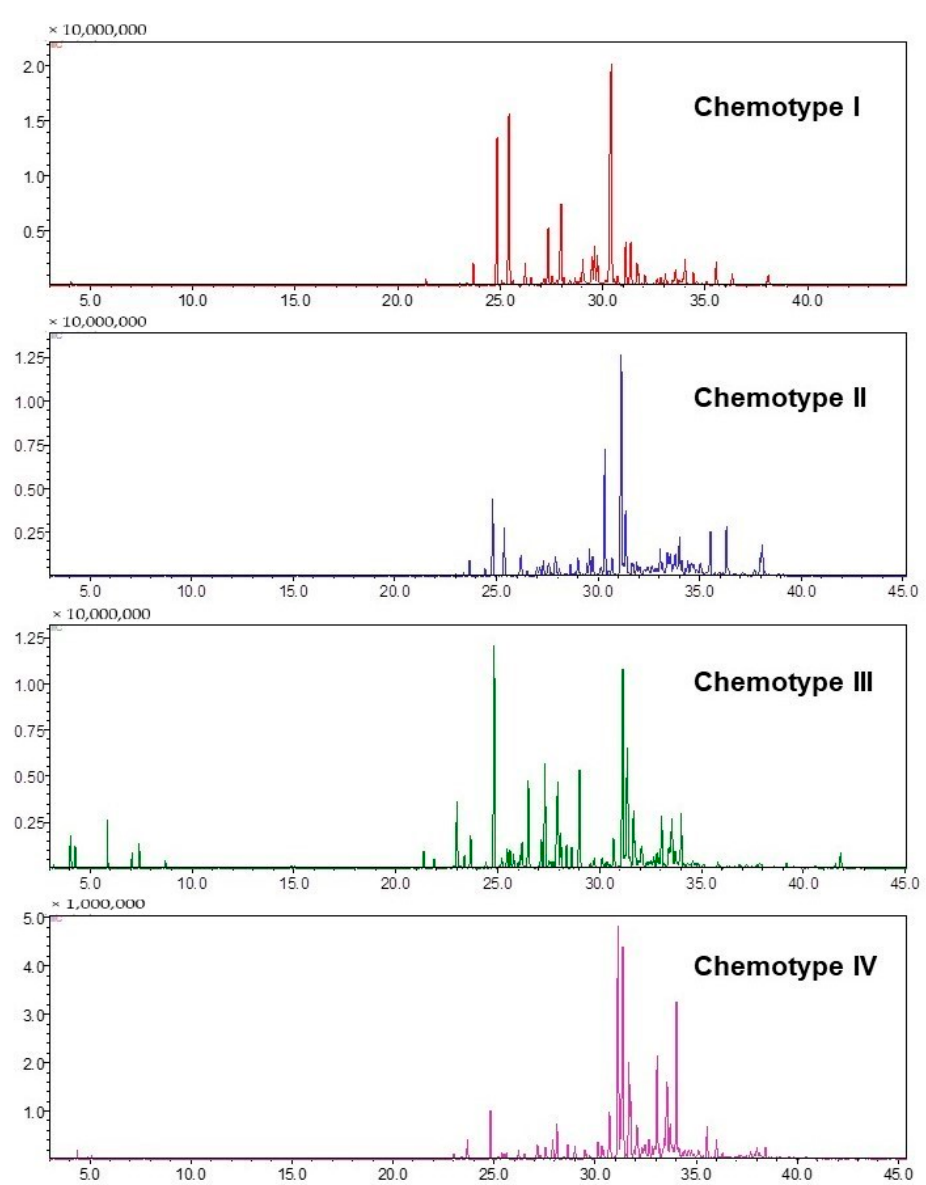
Figure A1. Gas chromatography chromatogram chemotypes of Myrcia sylvatica